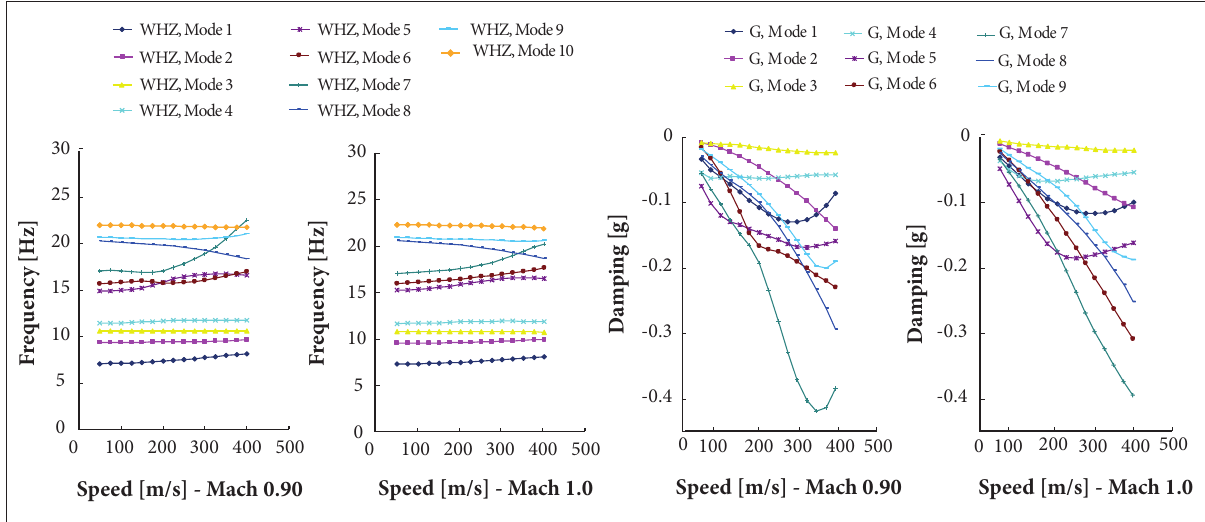
Figure 4. Non-matched aeroelastic analysis results — low subsonic